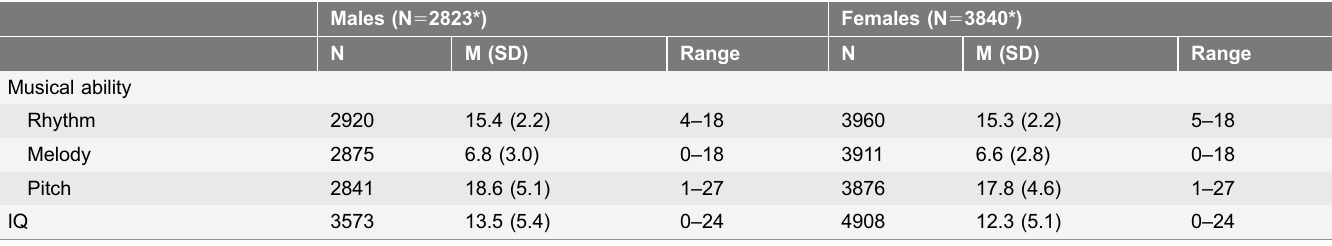
Table 1. Descriptive statistics.